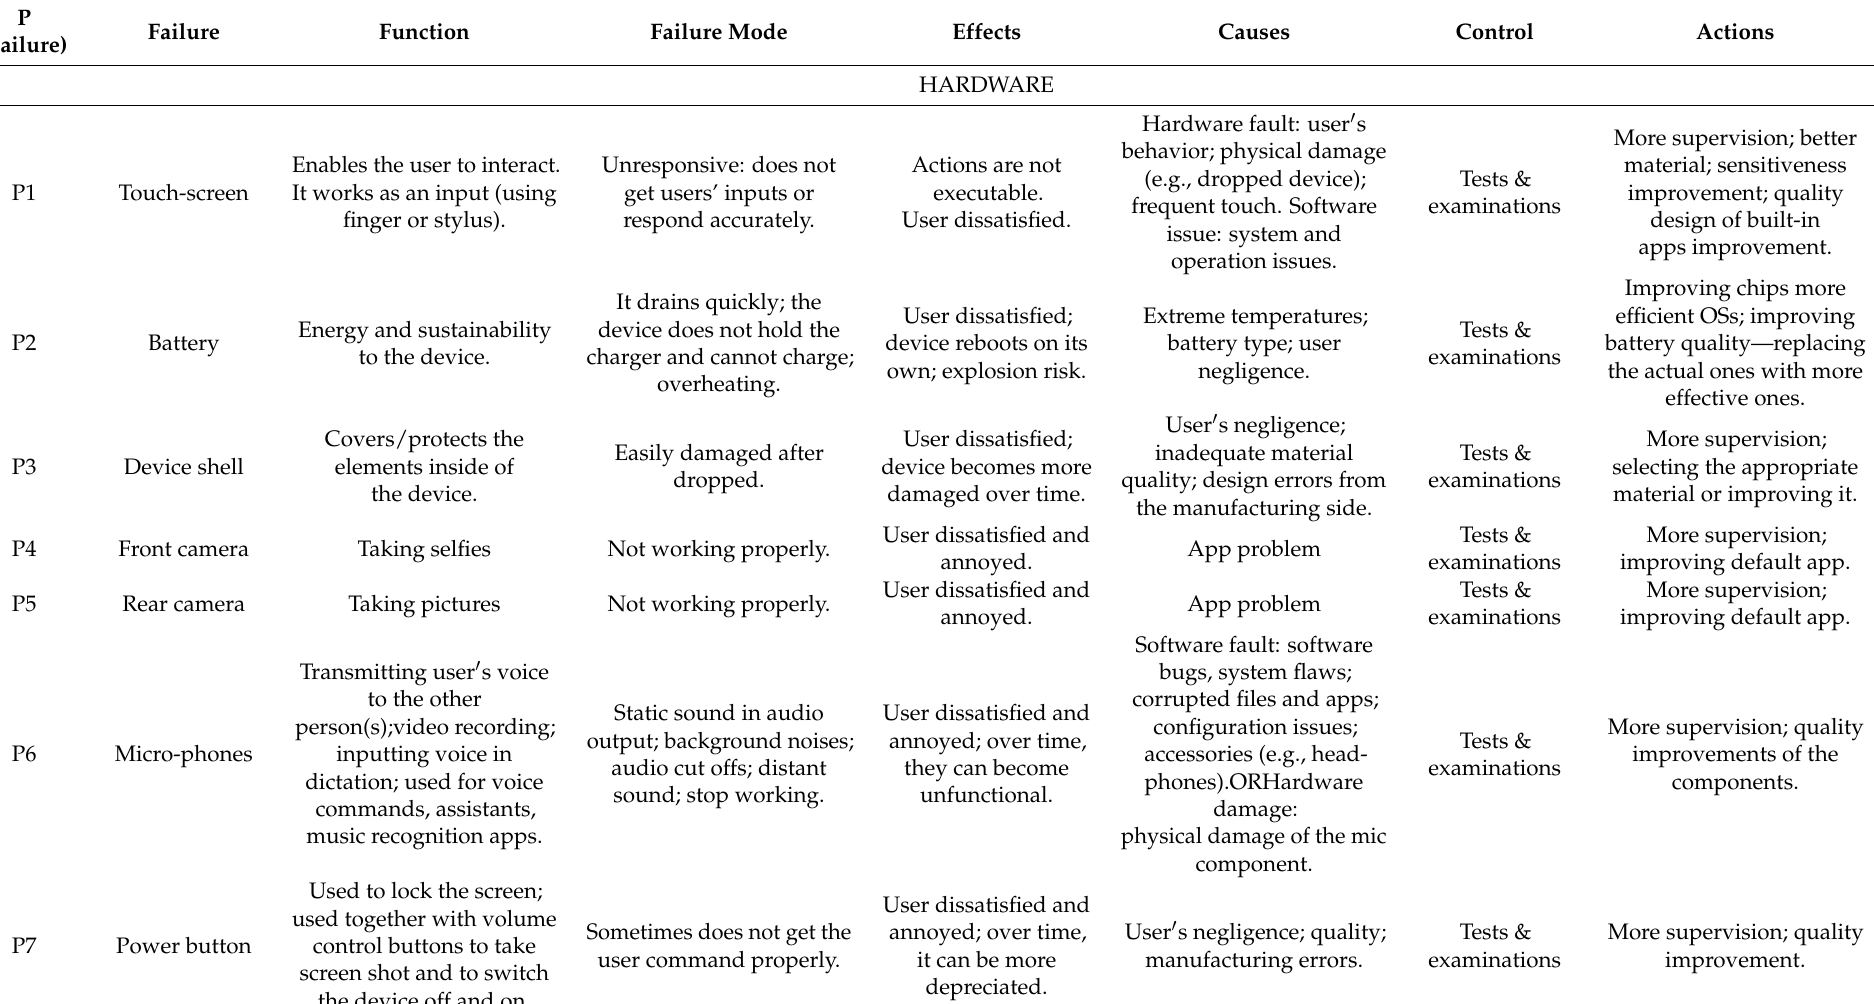
Table 1. Application of FMEA in